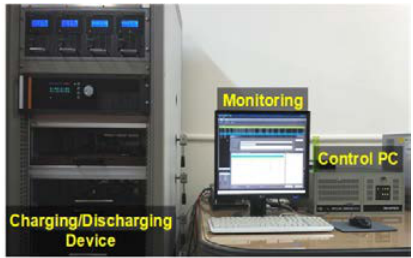
Figure 15. Charging / discharging test Figure 15. Charging/discharging test unit. Figure 15. Charging/discharging test unit.